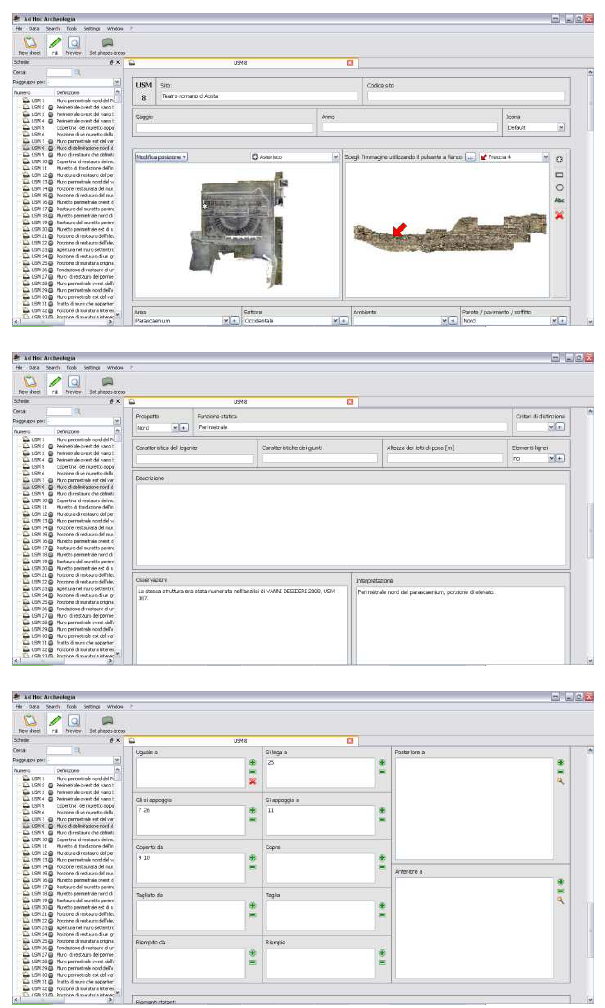
Figure 4. UUSS data Entry